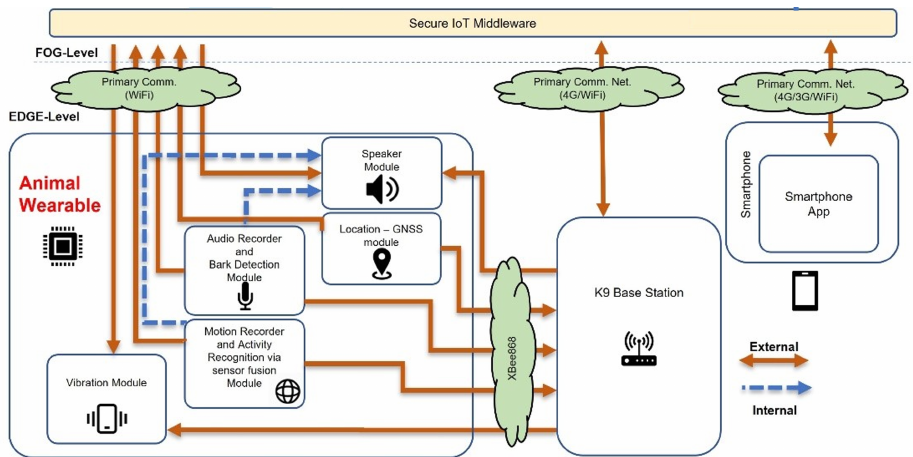
Figure 1. Wearable for animals—system architecture and communication